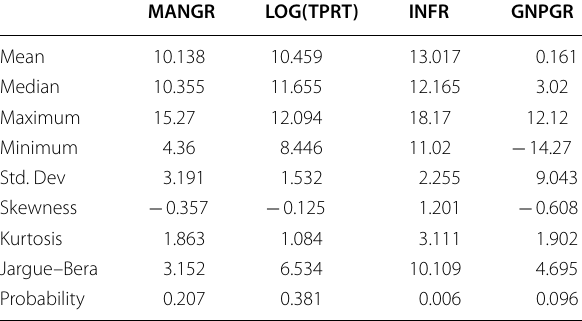
Table 1 Summary of descriptive analysis